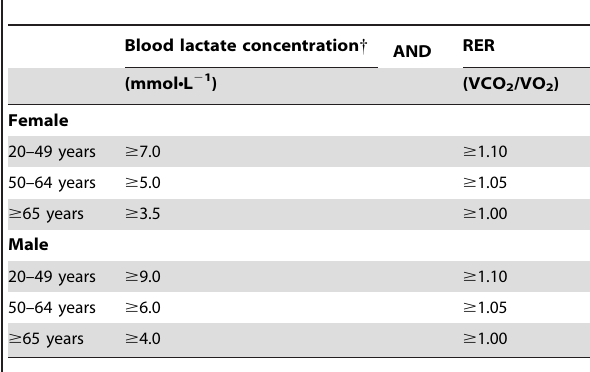
Table 4. New recommendations for maximal effort for haemolysed post exercise blood lactate* and respiratory exchange ratio